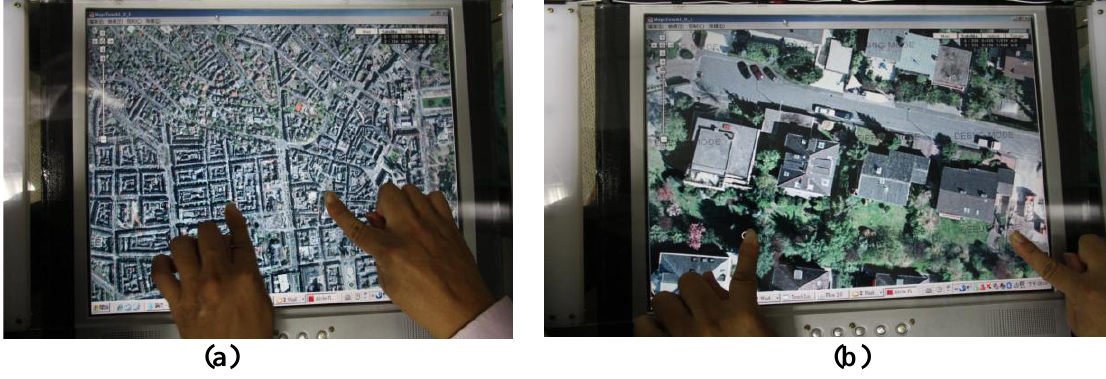
Figure 17. Example of performing the zooming in and zooming out commands on a Google Maps application using the proposed multi-touch sensing and display